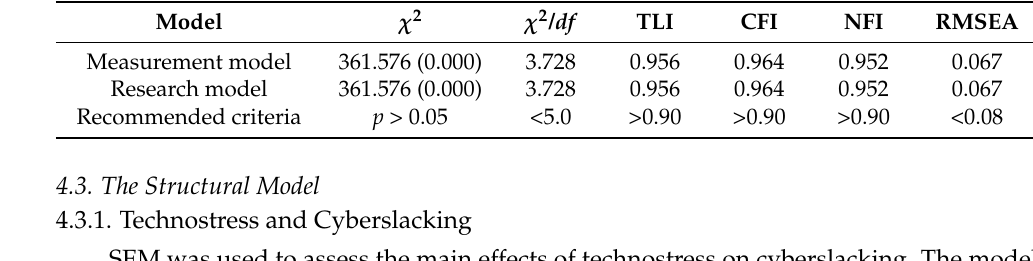
Table 4. The goodness of fit indices of the measurement model and the research model.